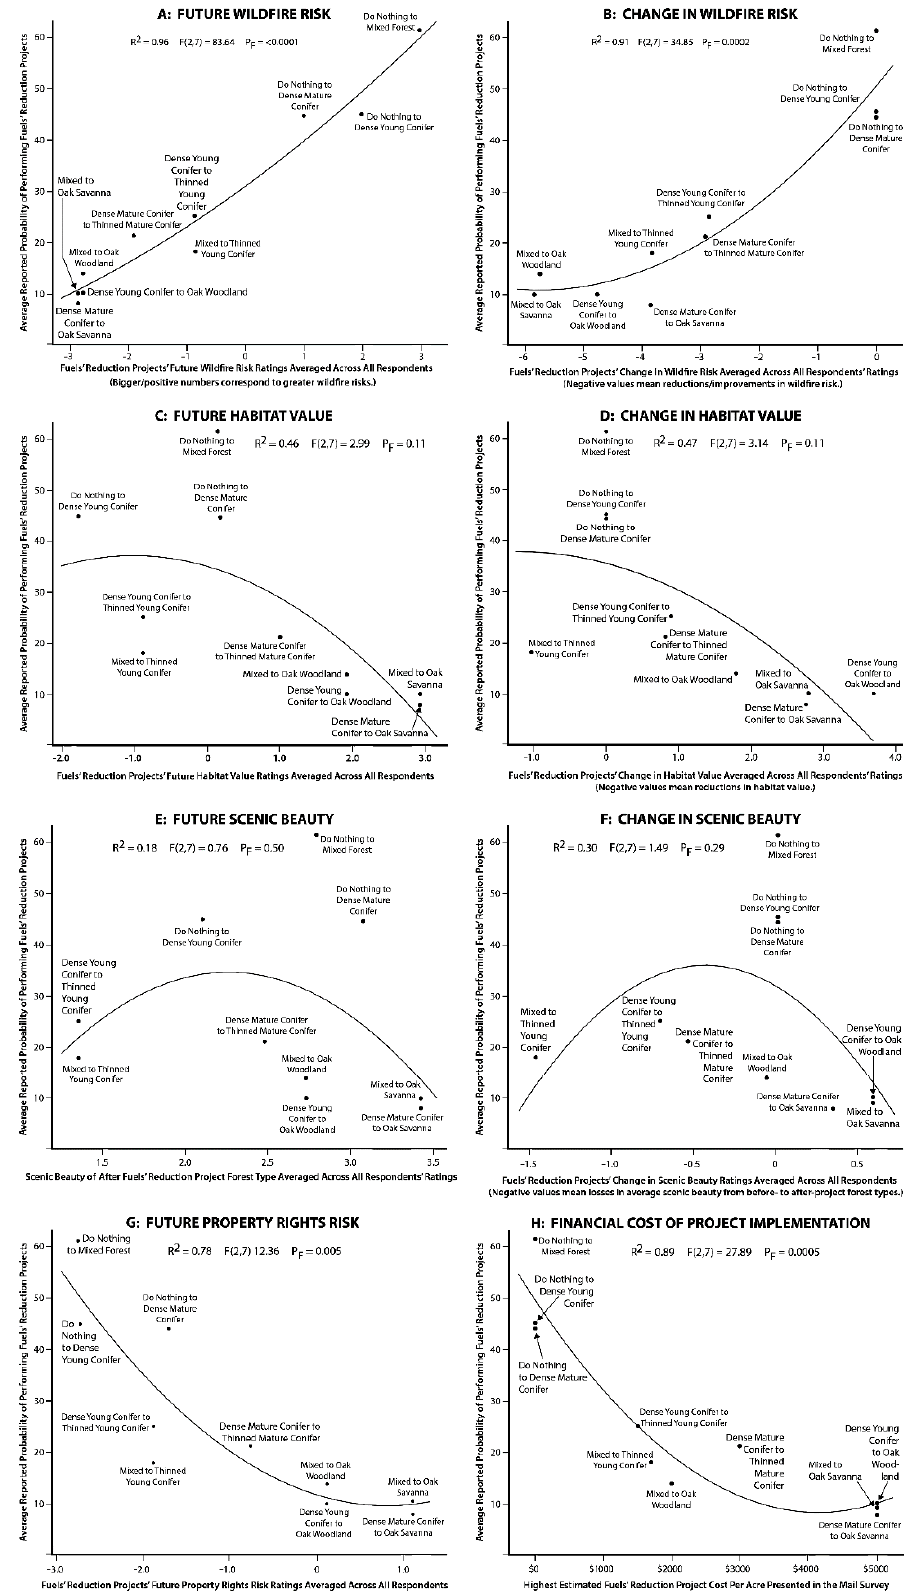
Figure 9. Relationship between fuels reduction propensities and attendant average ratings of corre- sponding forest attributes prior to regression analyses.